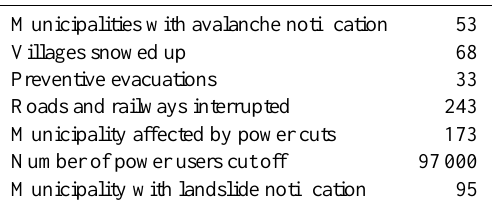
Table 2. The main criticalities of the 14–22 December 2008 snow- fall